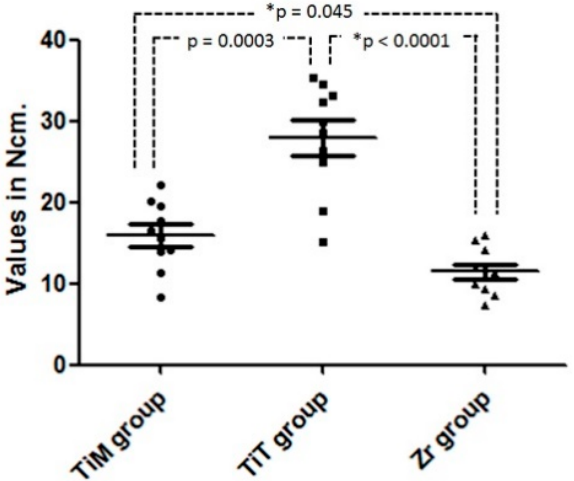
Figure 5. Graph of the removal torque dispersion values and statistical comparison of the groups. * Statistically difference ( p < 0.05).